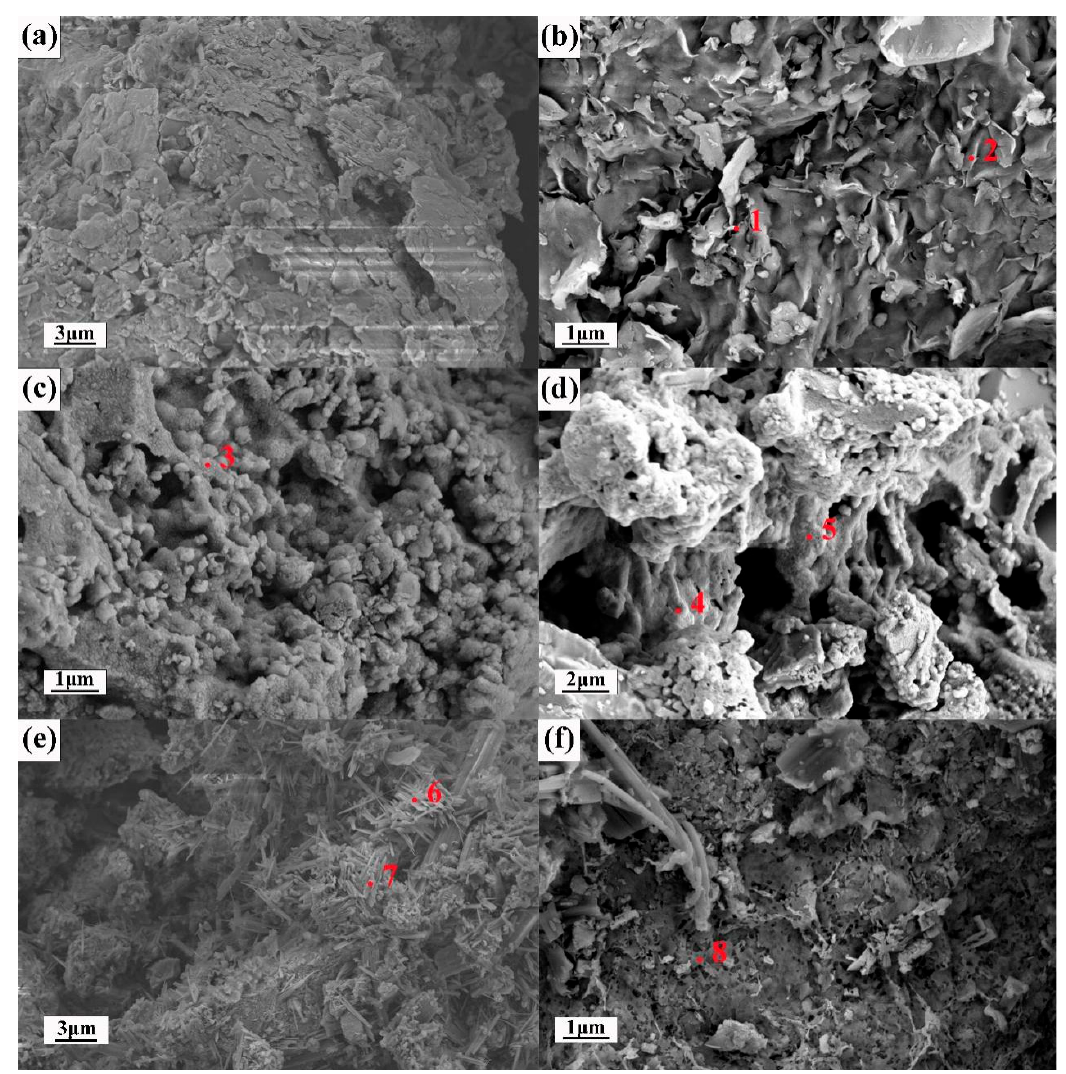
Figure 11. SEM images of samples. ( a ) Mag = 5.0 K X and ( b ) Mag = 5.0 K X samples of S, ( c ) Mag = 20.0 K X and ( d ) Mag = 5.0 K X samples of SG-1, and ( e ) Mag = 5.0 K X and ( f ) Mag = 10.0 K X samples of SC6G-5. (The red plot in fi gure is used for the SEM-EDS based on point scanning). Table 6. SEM-EDS of residue after leaching. (Atomic percent %). Plot